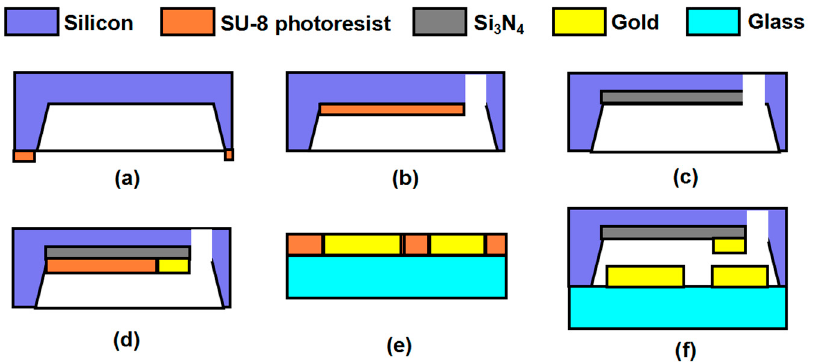
Figure 8. Variation of inertial stress.